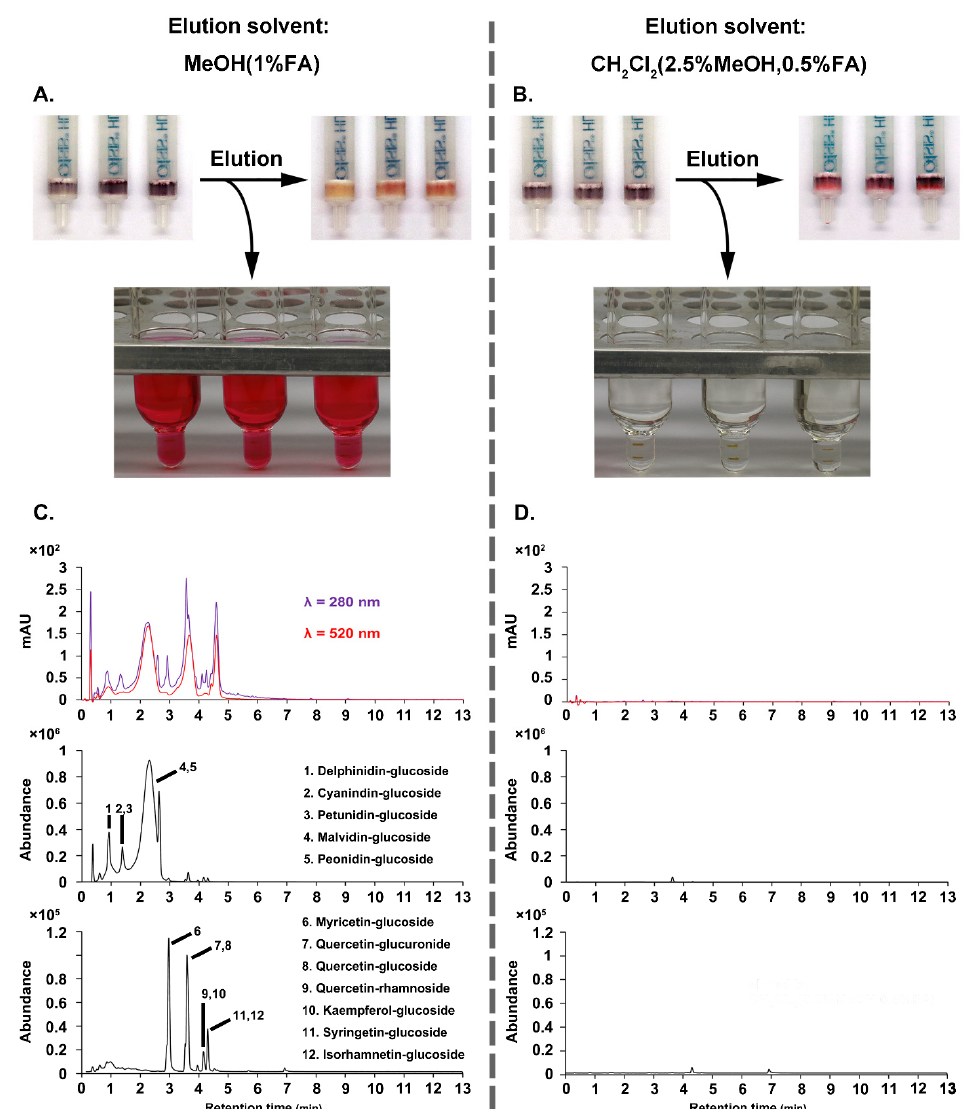
Figure 3. Comparison of the elution effects of two elution solvents: MeOH (1% FA) and CH 2 Cl 2 (2.5% MeOH, 0.5% FA). ( A ) The HLB cartridge before and after the elution and the sample solution after the elution using MeOH (0.1% FA) as the elution solvent. ( B ) The HLB cartridge before and after the elution and the sample solution after the elution using CH 2 Cl 2 (2.5% MeOH, 0.5% FA) as the elution solvent. ( C ) The three chromatograms detect the sample solution shown in ( A ) after concentration. The first chromatogram shows the absorption at 280 nm and 520 nm in samples using UHPLC-DAD. The second chromatogram shows the targeted analysis of anthocyanins and the third chromatogram shows the targeted analysis of non-anthocyanin phenolics in samples using UHPLC-QqQ-MS. Several compounds with high peak areas are marked in the chromatogram. ( D ) The three chromatograms detect the sample solution shown in ( B ) after concentration. The first chromatogram shows the absorption at 280 nm and 520 nm in samples using UHPLC-DAD. The second chromatogram shows the targeted analysis of anthocyanins and the third chromatogram shows the targeted analysis of non-anthocyanin phenolics in samples using